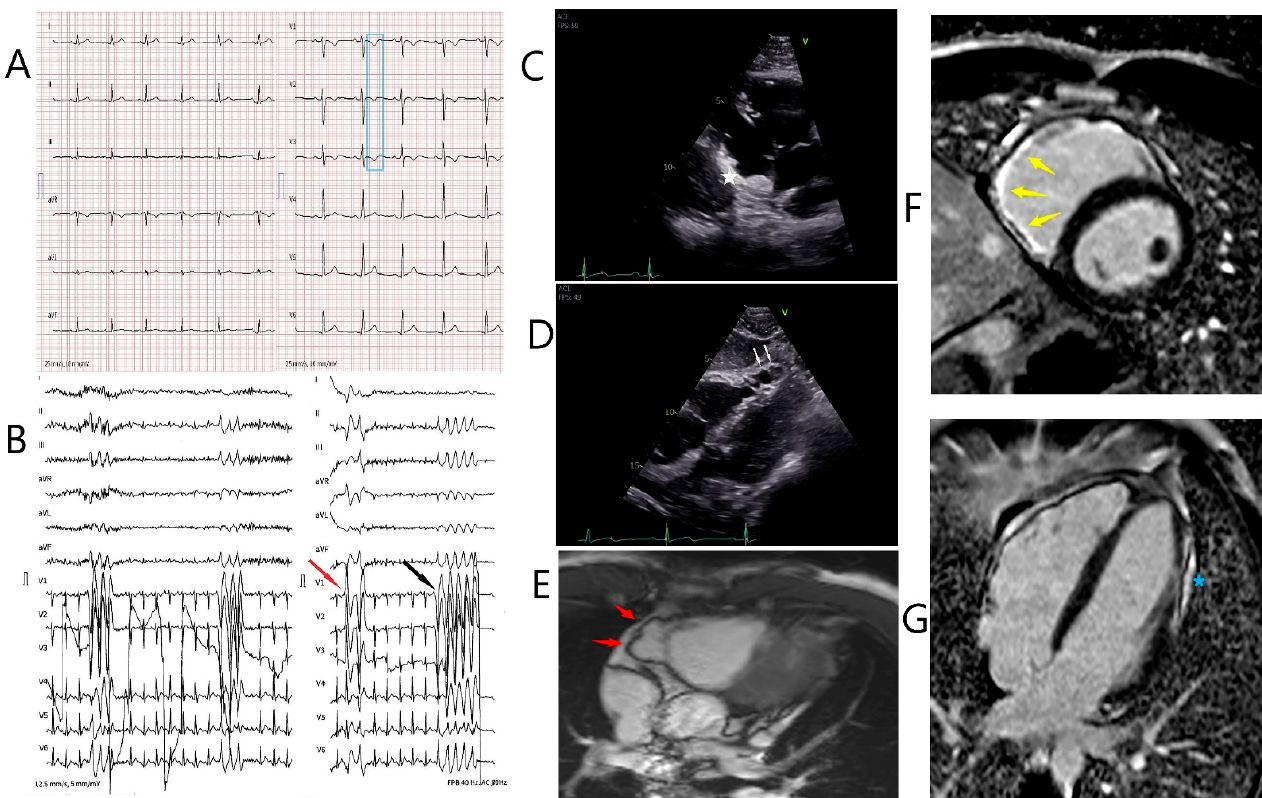
Figure 1. Diagnostic work-up in the index patient. ( A ). 12-lead electrocardiogram showing sinus rhythm with T wave inversions in V1–V3 (blue box). ( B ). Recovery phase of bicycle ergometry. Right (red arrow) and left bundle branch block (LBBB) morphology premature ventricular complexes and non-sustained ventricular tachycardia with a LBBB morphology (black arrow) and an inferior axis are shown. ( C , D ). Transthoracic echocardiogram showing the subtricuspid aneurysm (white asterisk) on the RV inflow view and multiple sacculations of the right ventricular free wall (white arrows). ( E ). Multislice 4 chamber MRI view showing a subtricuspid aneurysm of the right ventricular free wall (red arrows). ( F ). Late gadolinium enhancement of the subtricuspid right ventricular wall (yellow arrows, Phase-sensitive inversion recovery (PSIR) short axis view). ( G ). Late gadolinium enhancement of the lateral wall of the left ventricle (blue asterisk, PSIR 4 chamber view).